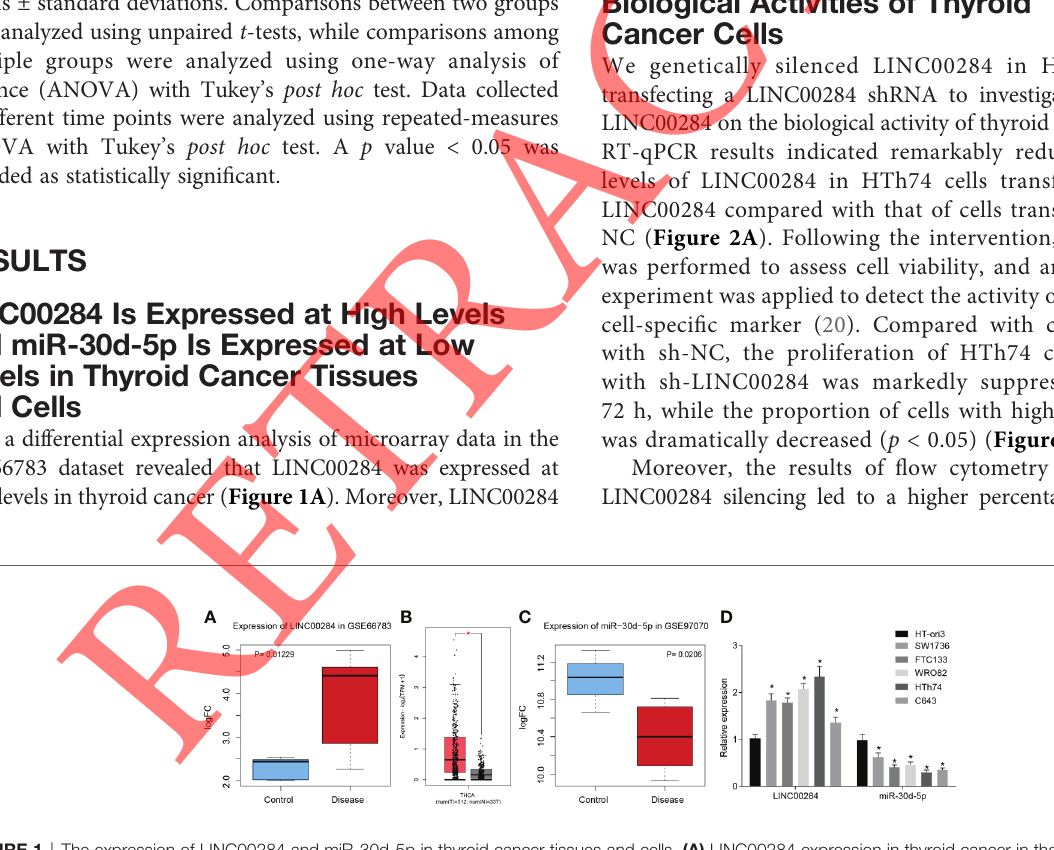
FIGURE 1 | The expression of LINC00284 and miR-30d-5p in thyroid cancer tissues and cells. (A) LINC00284 expression in thyroid cancer in the GSE66783 microarray. (B) LINC00284 expression in thyroid cancer in the TCGA database; the abscissa represents the sample type, the ordinate represents the expression level, the red box indicates tumor samples, and the gray box indicates normal samples; *q < 0.01. (C) The GSE97070 microarray dataset showed that miR-30d-5p was downregulated in thyroid cancer. (D) The expression levels of LINC00284 and miR-30d-5p in HT-ori3, SW1736, FTC133, WRO82, HTh74, and C643 cell lines. * p < 0.05 compared with HT-ori3 cells. Data are presented as the means ± standard deviations, data were compared between two groups using unpaired t- test, and the experiments were repeated three